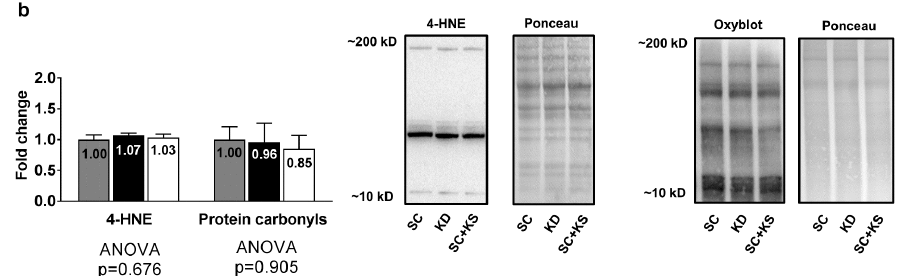
Figure 6. Brain oxidative stress-related proteins and markers in 8 month-fed rats. Legend: Brain catalase (Cat), glutathione peroxidase (Gpx), and mitochondrial superoxide dismutase (Sod2) protein levels are presented with representative images in panel ( a ). In panel ( b ), tissue 4-Hydroxynonenal (4-HNE), and protein carbonyls (Oxyblot) are presented with representative images. Fold-change for each protein are expressed relative to the SC group, all bars are presented as mean ± standard error values ( n = 7–8 per group), group means are indicated within each bar and ANOVA p -values are presented below data. Abbreviations: SC, standard chow-fed rats; KD, ketogenic diet-fed rats; SC + KS, standard chow-fed rats with supplemental sodium beta-hydroxybutyrate.